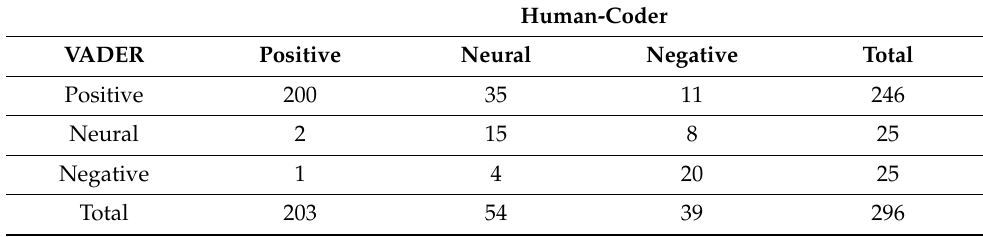
Table 3. Annotation results.